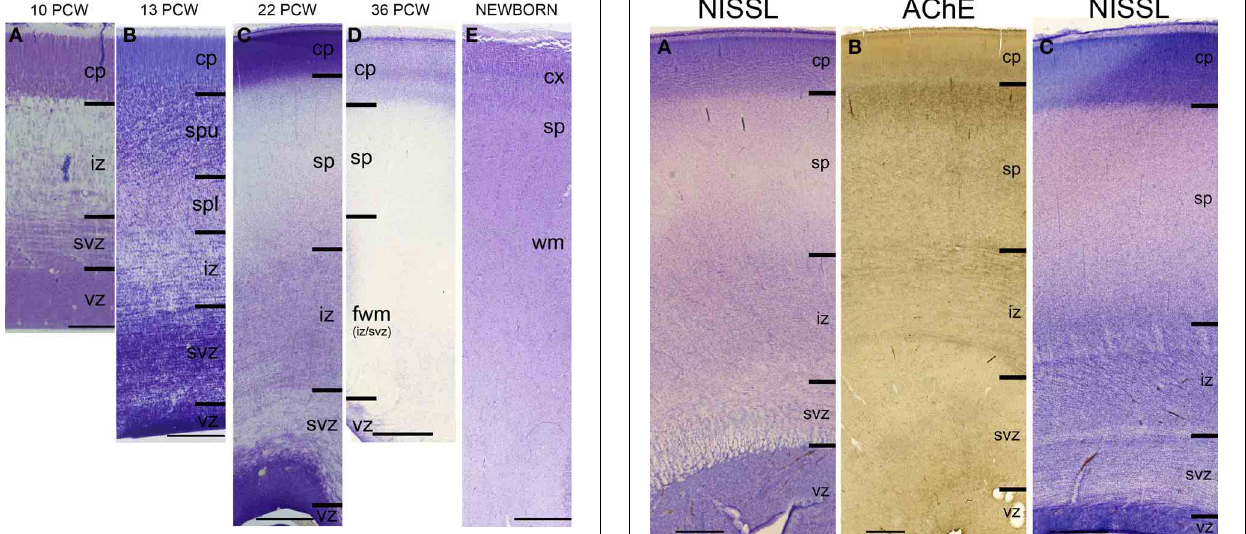
FIGURE 2 | Lamination of frontal (A), mid-central (B) and occipital (C) region of human telencephalon at the peak of subplate development (22–24PCW), as revealed by Nissl staining and acetylcholinesterase (AChE) histochemistry. At the peak of subplate development (22–24PCW), subplate zone is the largest compartment of the human telencephalon. It is the place of intense synaptic activity and “waiting” compartment for the thalamocortical fibers (dark band below cp). Note that there are regional differences in the lamination between frontal and occipital region. cp, cortical plate; sp, subplate zone; iz, intermediate zone; svz, subventricular zone; vz, ventricular zone. Bar =